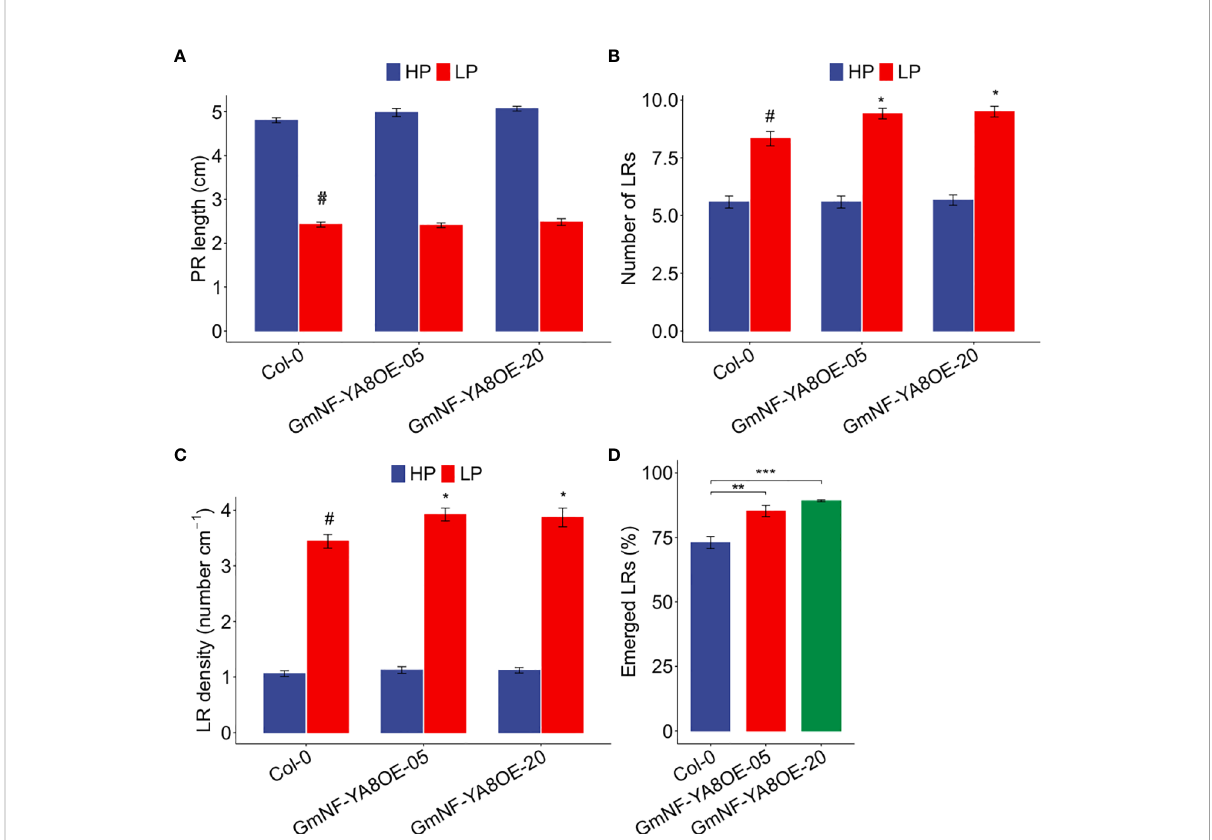
FIGURE 10 Ectopic expression of GmNF-YA8 increases number of lateral roots (LRs) under low P (LP) conditions, and boosted the percentage of emerged LRs under LP. (A) Primary root (PR) length; (B) Number of LRs; (C) LR density; (D) Emerged LRs (%). Results are means ± SE of three independent experiments. Student ’ s t -test was used to compare the differences between Col-0 and the transgenic lines GmNF-YA8OE-05 and GmNF- YA8OE-20 (* P < 0.05; ** P < 0.01; *** P < 0.001; #, the